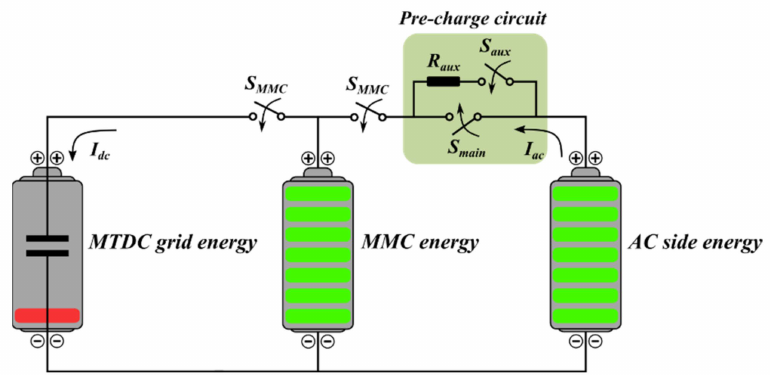
Figure 8. Simplified illustration of MTDC grid energy level after DC fault clearance.